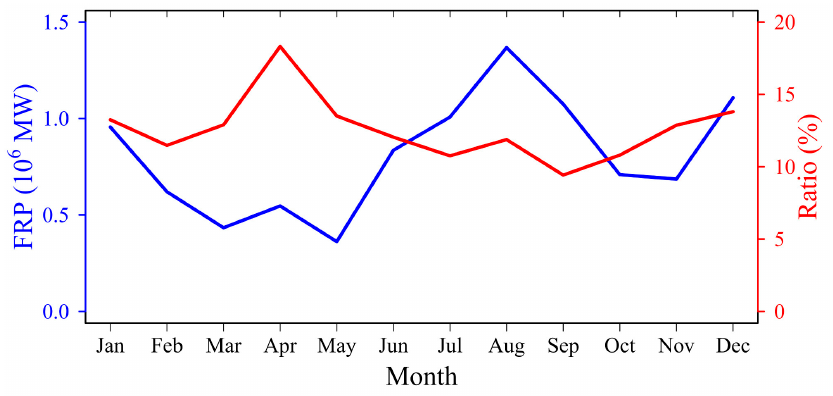
Figure 10. Seasonal variations of VIIRS FRP observed inside MODIS swath gaps (blue) and the ratio (red) of the VIIRS FRP inside to outside MODIS swath gaps across Africa in 2017.